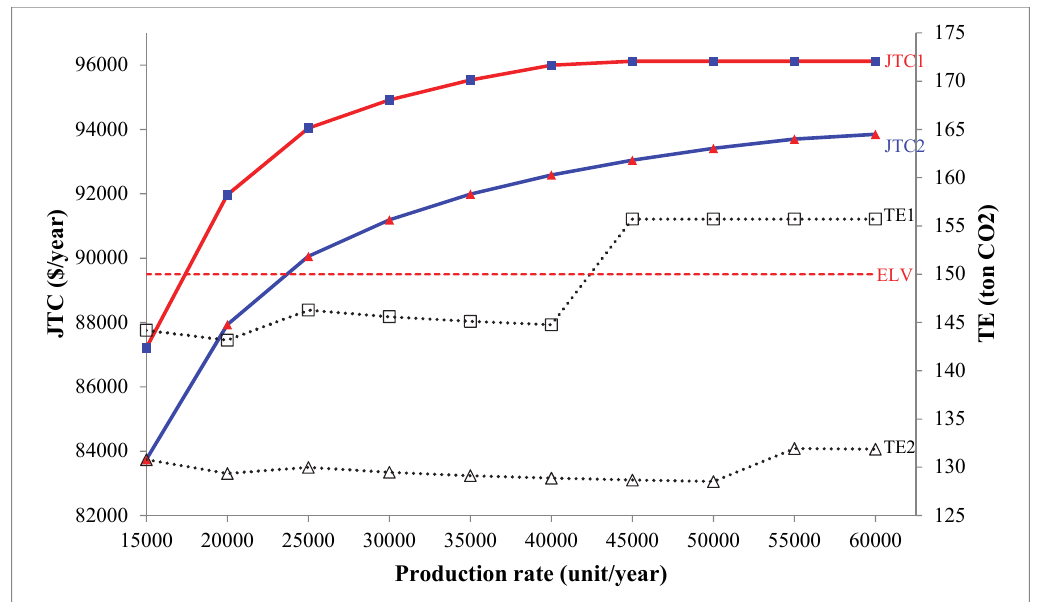
Fig. 8. The effect of changing in production rate on total cost and total